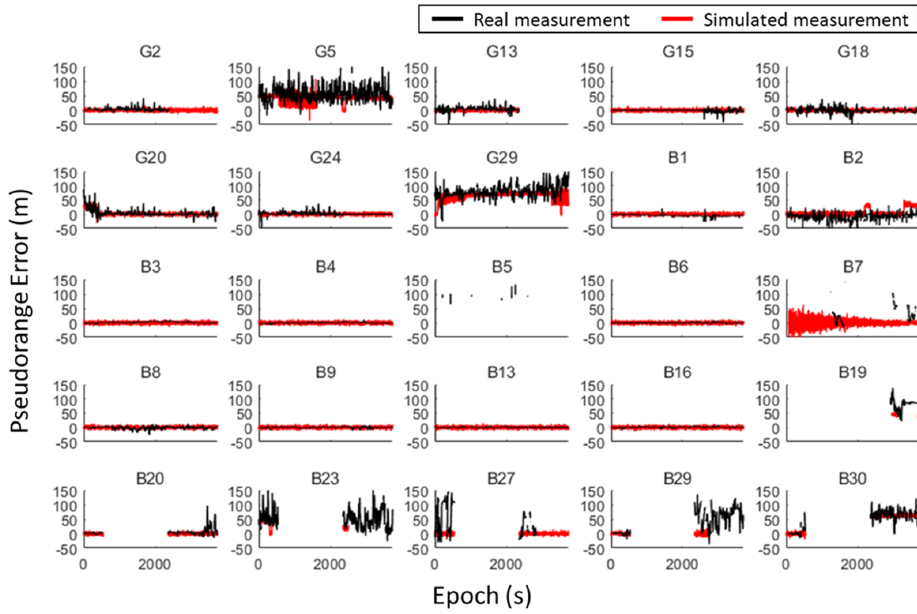
Figure 15. The simulated pseudorange error and corresponding labeled value in real measurements for each satellite during the long-period static experiment. Table 4. The difference in mean value (standard deviation) between simulation and real data.